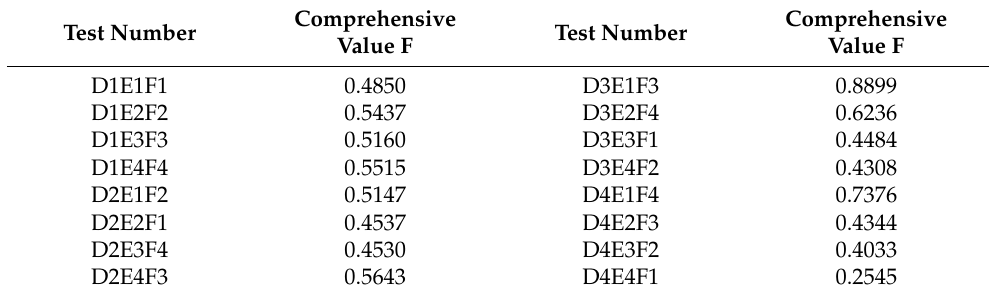
Table 8. Data processing results of the test for the performance of spraying pesticides.